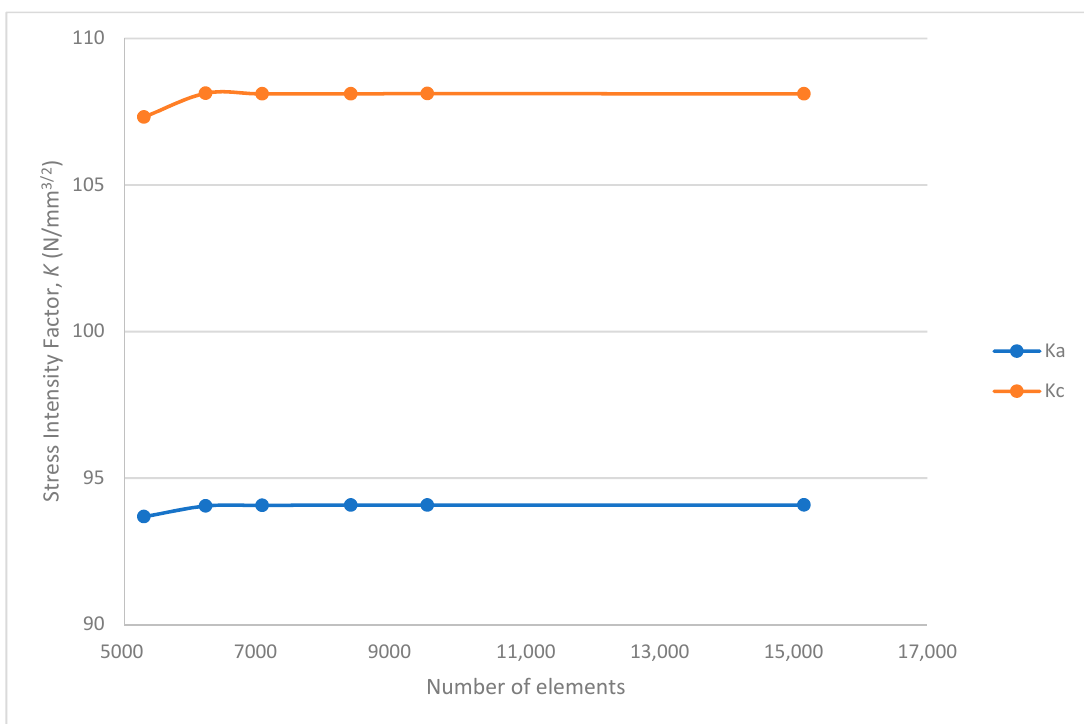
Figure 11. Mesh convergence study showing that the mesh element size in the region of less interest, such as the thickness direction of the pipe, does not significantly affect the SIF results.